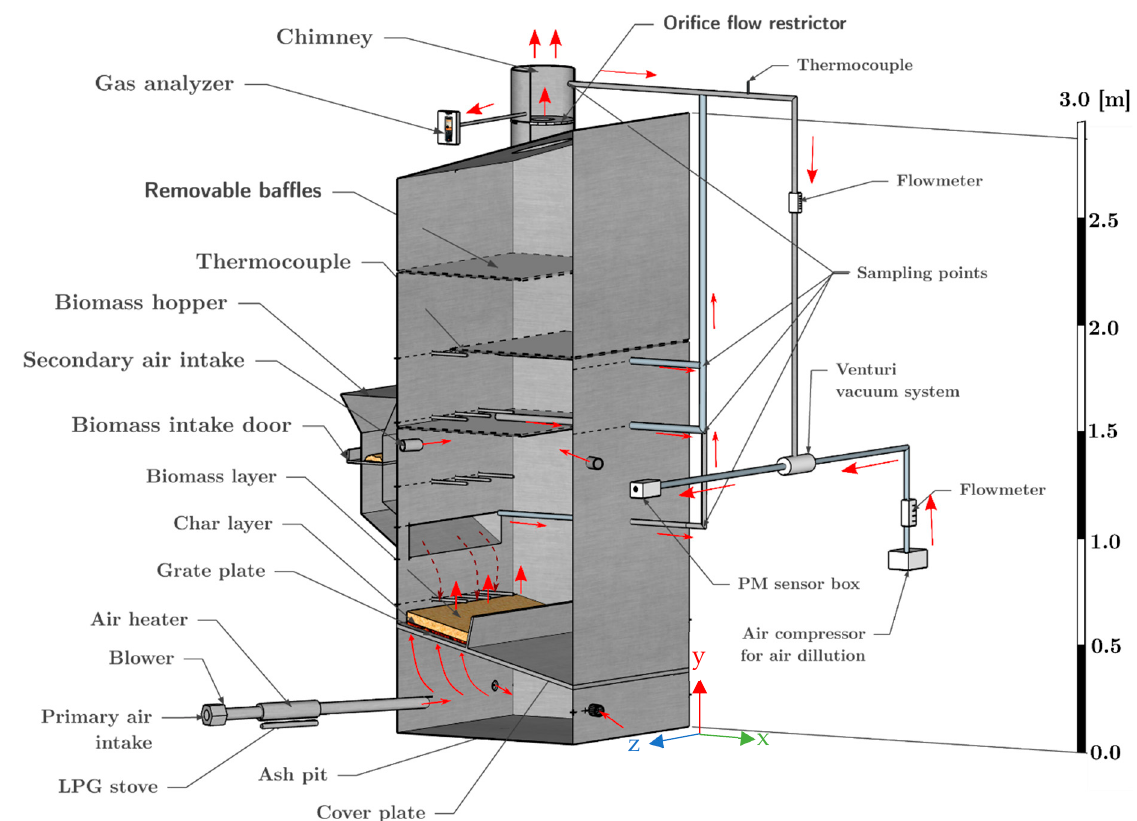
Figure 1. Schematic view of the grate-fired furnace (red arrows indicate the gas flow and dashed brown arrows show biomass movement).